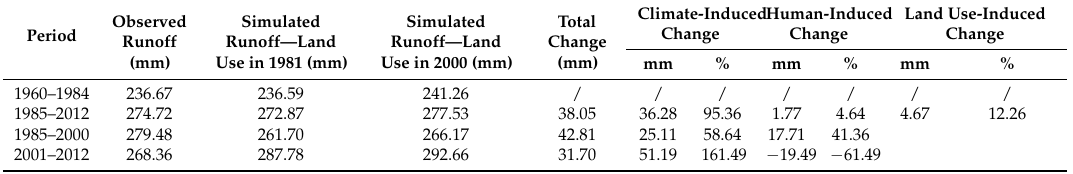
Table 6. Results of attribution analysis for runoff change in the Qingliu River basin on annual